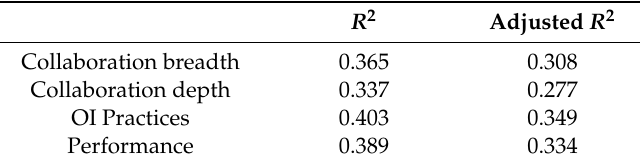
Table 14. Coe ffi cient of determination ( R 2 values).